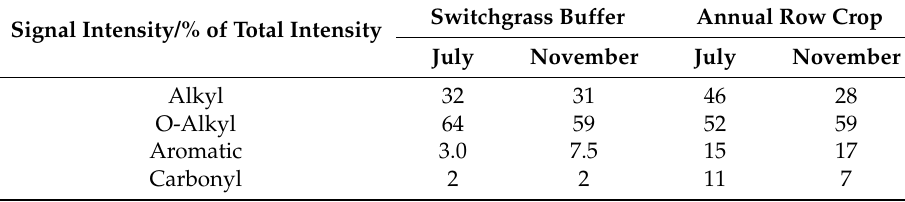
Table 4. The relative proportion of different types of carbon in the light particulate organic matter (LPOM-C) at a depth of 0–15 cm under switchgrass buffer and non-buffered annual row crop. The chemical composition of LPOM samples were examined with a solid-state 13 C nuclear magnetic resonance